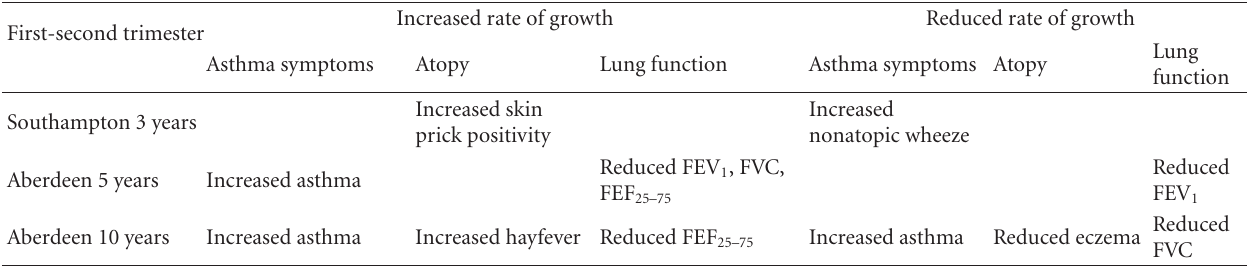
Table 2: Summary of asthma and allergy outcomes in the context of changing growth trajectory during early pregnancy.